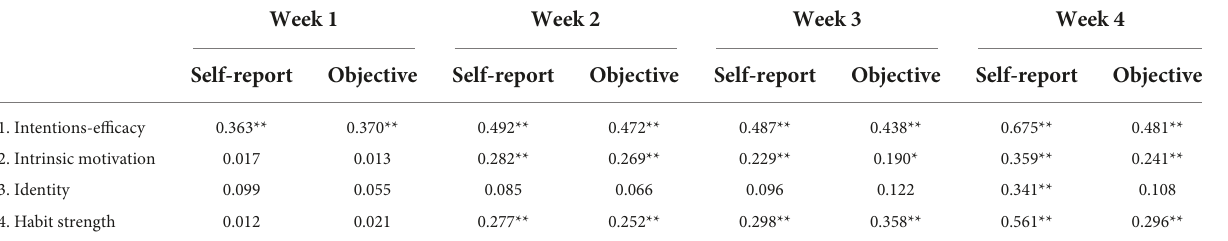
TABLE 1A Correlation results for calcium supplementation variables.